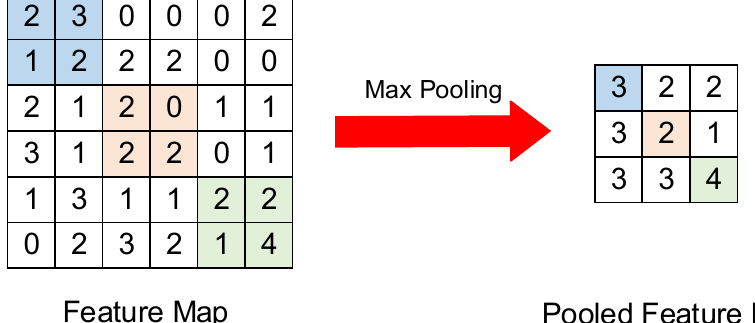
Figure 5. Diagram of operations performed by the pooling layer.